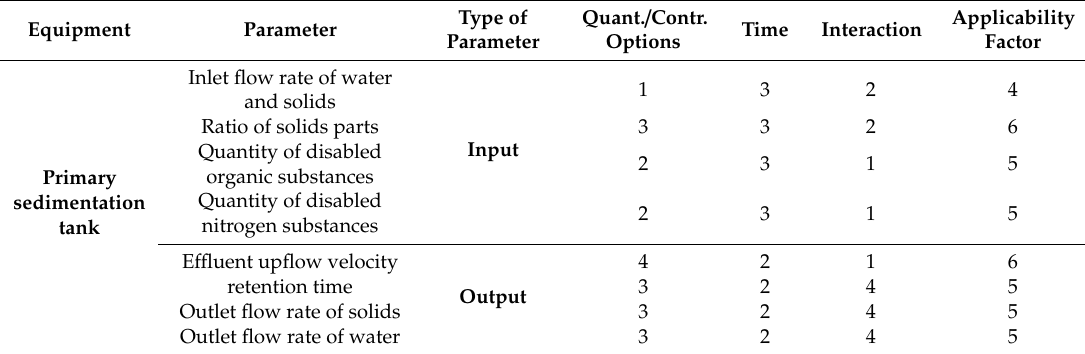
Table 9. Evaluation parameters of the primary sedimentation tank.